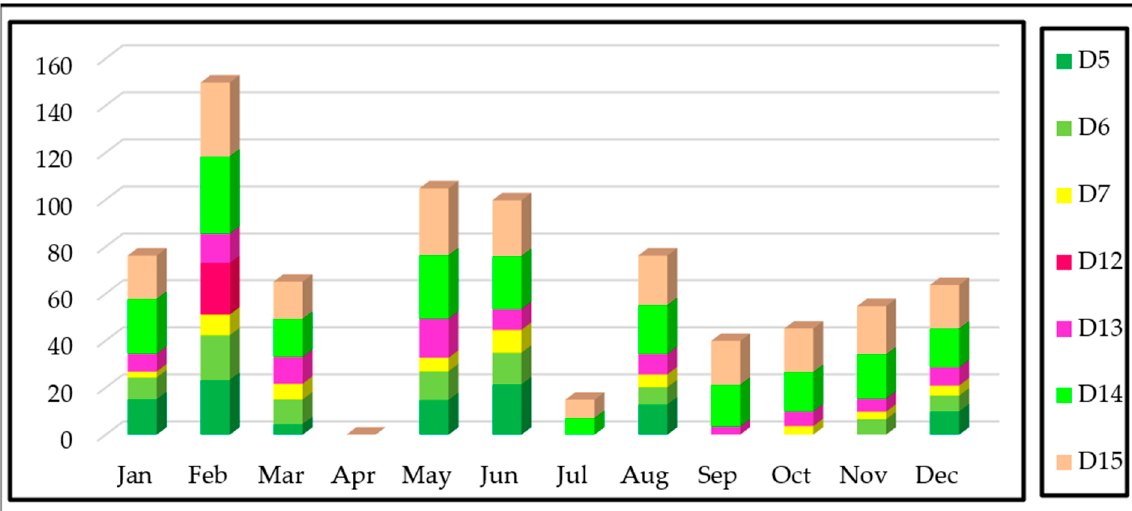
Figure 5. Monthly unmet demand for the current conditions for all demand nodes (MCM). The total surface water delivered to the study area is 4577.26 Mm 3 /year only,